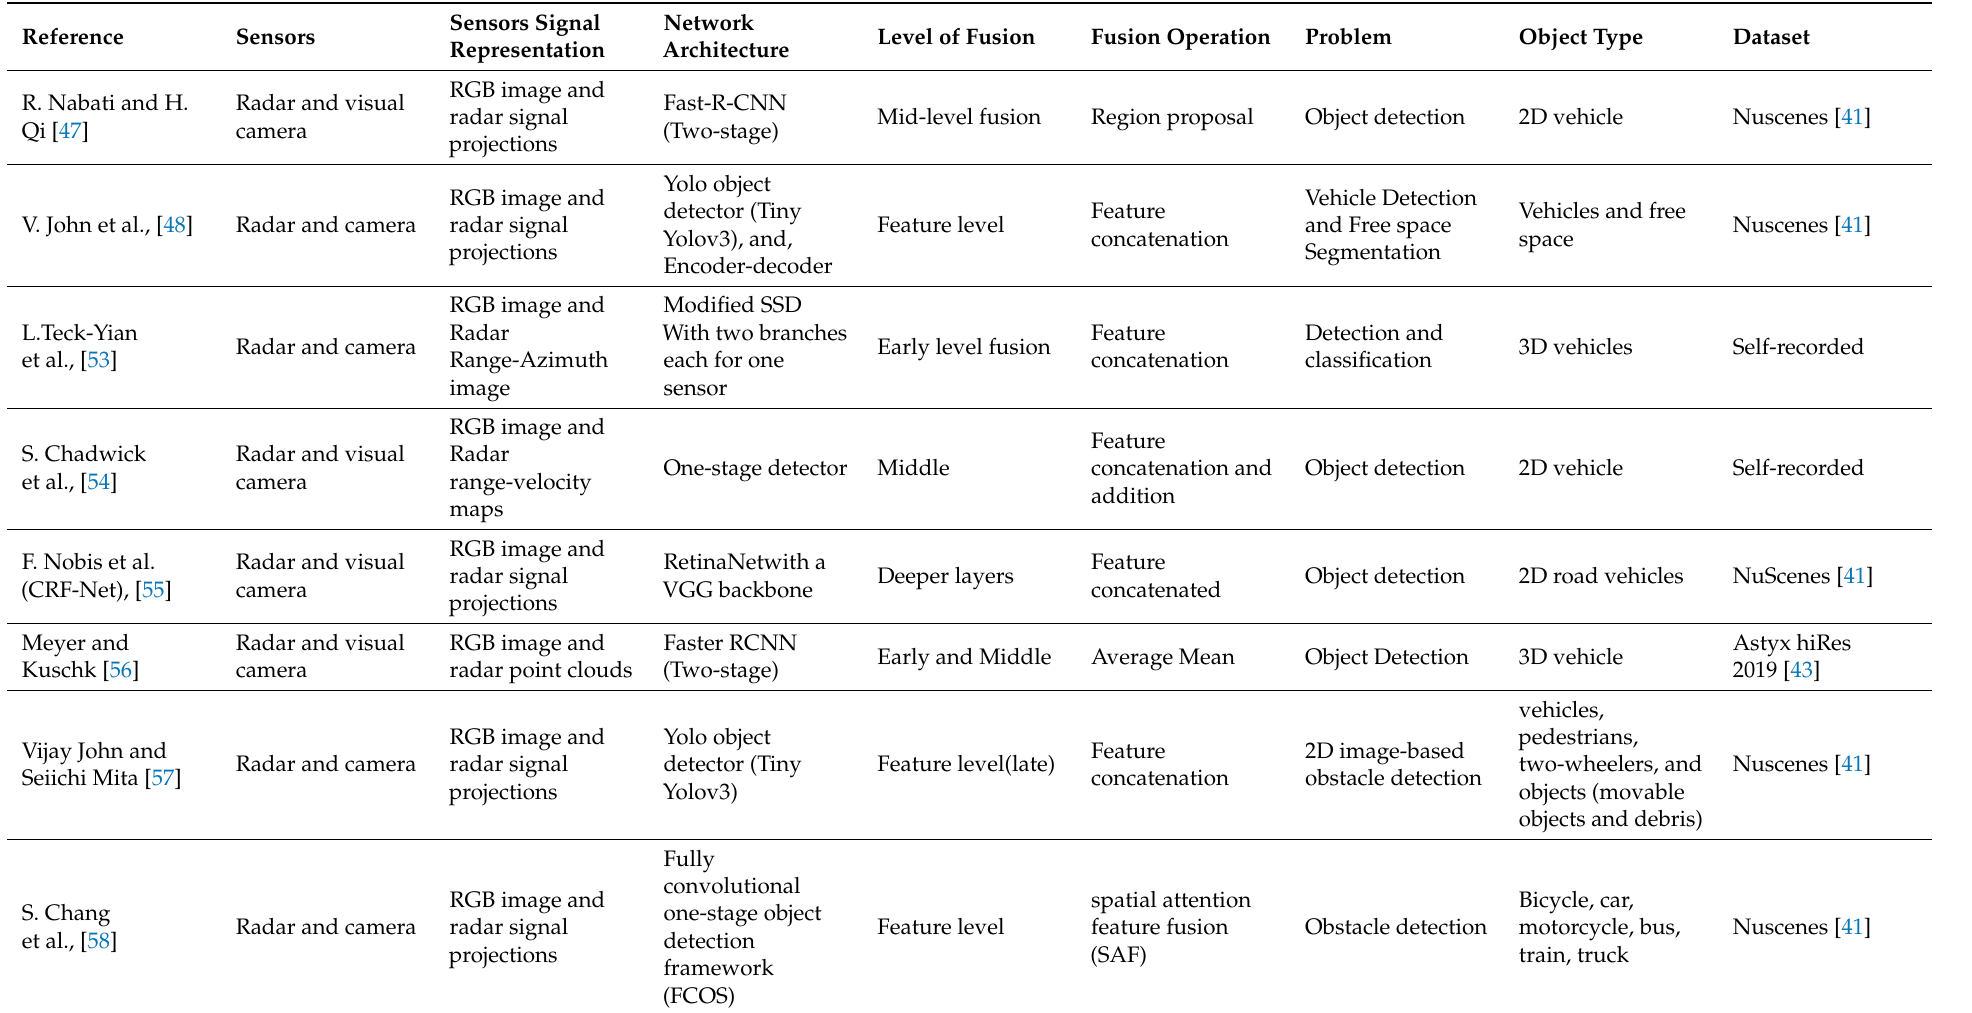
Table 2. A summary of deep learning-based fusion methods using radar and vision